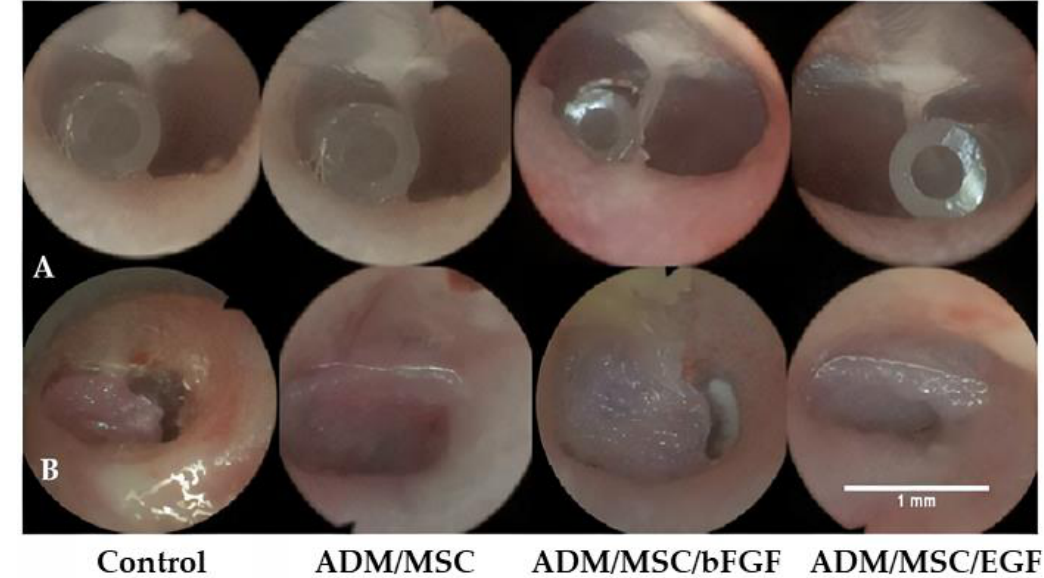
Figure 1. Otoendoscopy shows well patent ventilation tube (angiocatheter). Three groups: left anterior area, acellular dermal matrix/mesenchymal stem cell/epidermal growth factor (ADM/MSC/EGF) group: right anterior ( A ). Otoendoscopy shows the placement of each scaffold (3 mm diameter). They are placed fine in an overlay fashion ( B ).